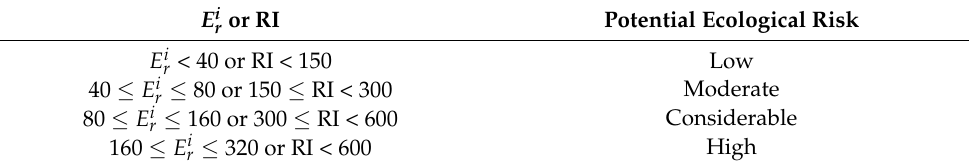
Table 2. Classification standard of the potential ecological risk of heavy metals. E i r or RI Potential Ecological Risk E i r < 40 or RI <